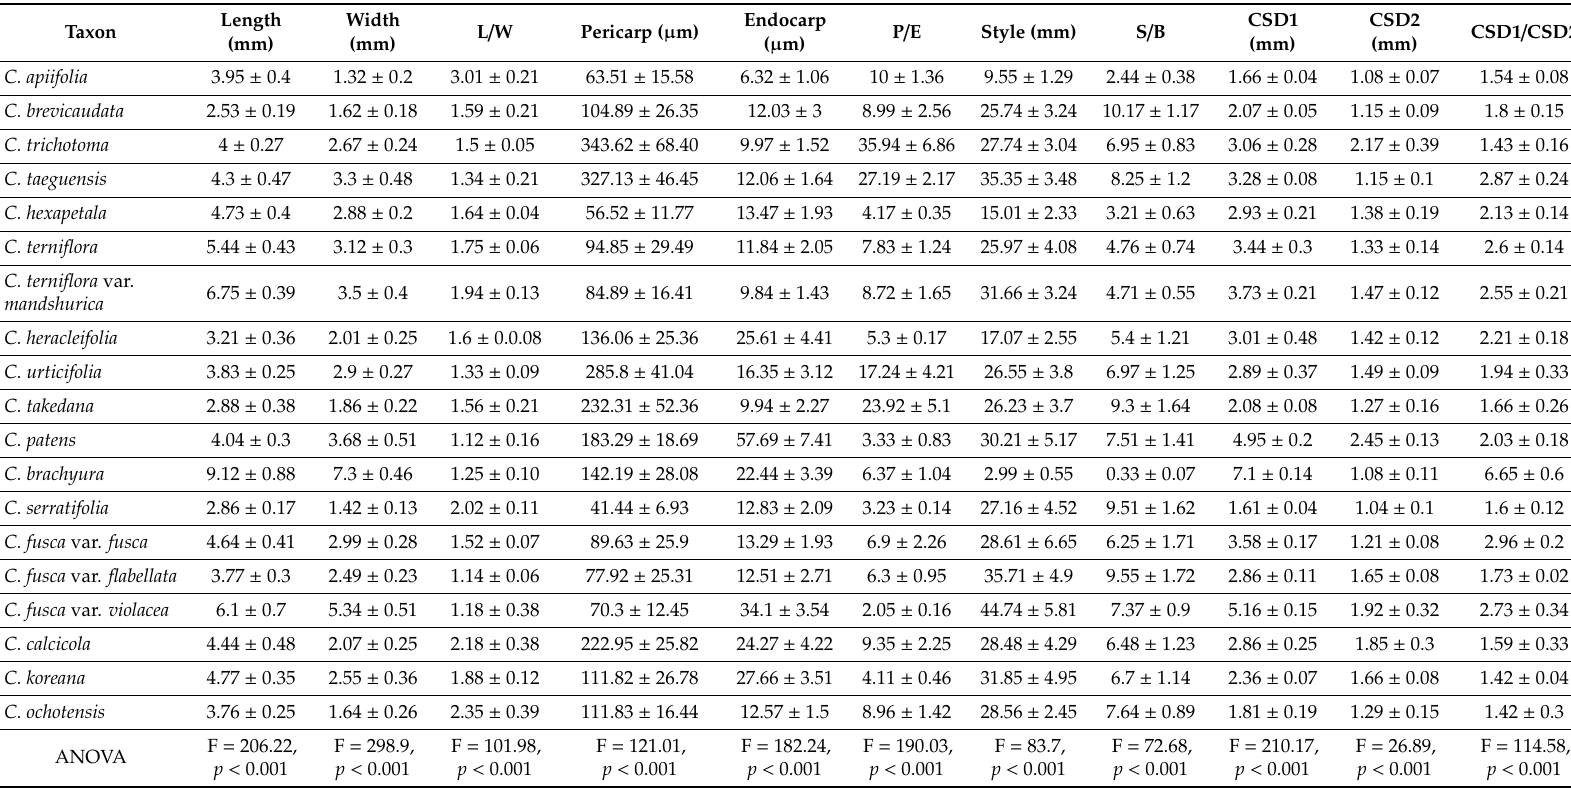
Table 3. One-factor ANOVA for the achene characters and their measurements in Clematis taxa (mean and standard deviation). L / W = length and width ratio, P / E = pericarp and endocarp ratio, S / B = style and achene body ratio, CSD1 = diameter parallel to cotyledon, CSD2 = diameter perpendicular to cotyledon, D1 / D2 = CSD1 and CSD2